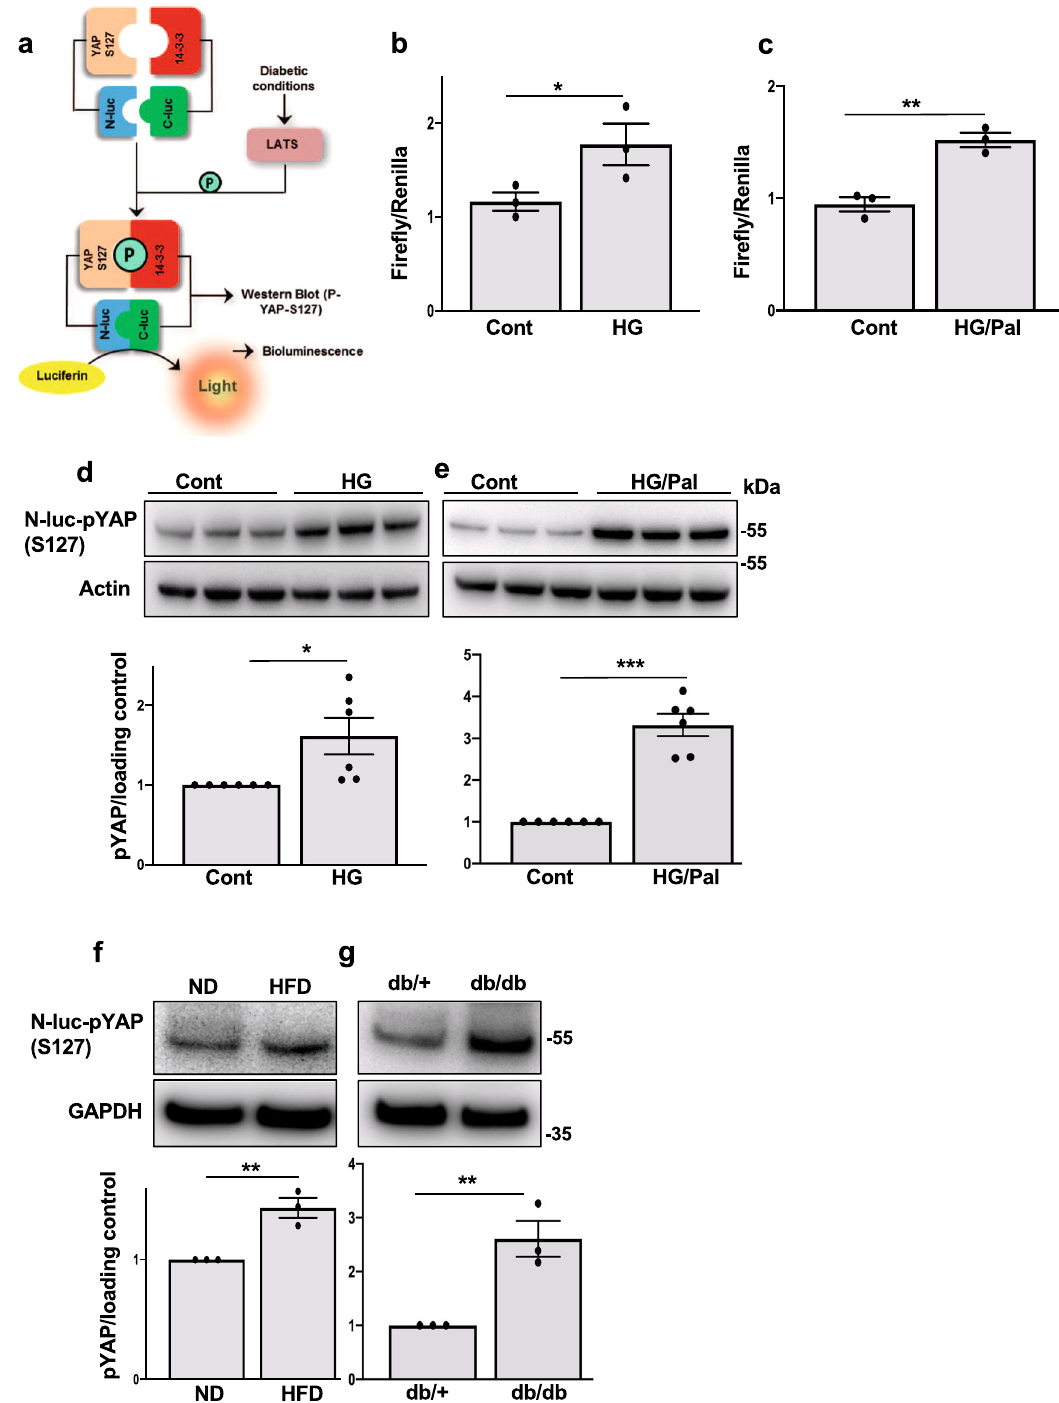
Fig. 1 LATS2 is activated under diabetogenic conditions. a Schematic structure and mechanism of action for LATS-BS. b – e INS-1E cells transfected with the fi re fl y luciferase reporter plasmids N-luc-YAP15-S127, C-luc-14-3-3, and pRL-Renilla luciferase were treated with 22.2 mM glucose alone or in combination with 0.5 mM palmitate for 24 h. b , c Downstream phosphorylation of the exogenously expressed YAP-S127 fragment was determined by fi re fl y luciferase activity and normalized to the Renilla signal ( n = 3 biologically independent samples). d , e Representative western blots and pooled quantitative densitometry analysis for exogenously expressed YAP-127 by a phospho-speci fi c antibody are shown ( n = 6 biologically independent samples). Isolated islets from f HFD-treated C57BL/6 J mice for 16 weeks or g the obese diabetic leptin receptor-de fi cient db/db mice and their corresponding controls cultured overnight and transfected with the N-luc-YAP15-S127 plasmid for 24 h. Representative western blots and pooled quantitative densitometry are shown ( n = 3 independent experiments) and results were normalized to the respective control conditions and ratios, in which a normal distribution of results cannot be proven, were analyzed. Data are expressed as means ± SEM. * p < 0.05, ** p < 0.01, *** p < 0.001; all by two-tailed Student ’ s t-